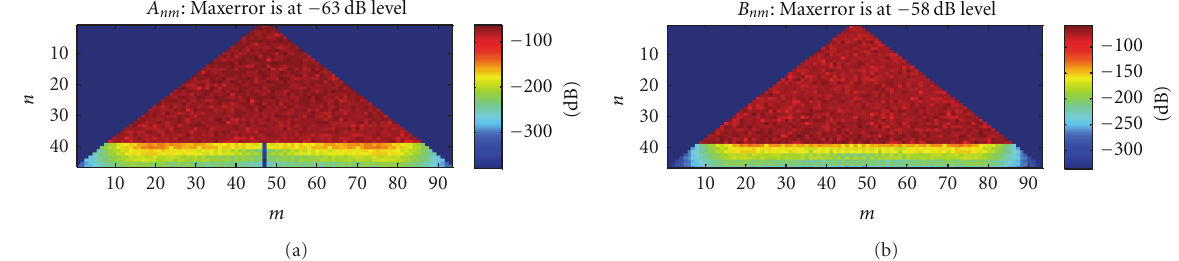
Figure 7: Error plots of the spherical expansion coe ffi cients computed from the higher-order probe output with ψ = 2 ◦ by truncating the M matrix in the presence of Gaussian probe-output noise at the − 60dB level. (a) is E (38)